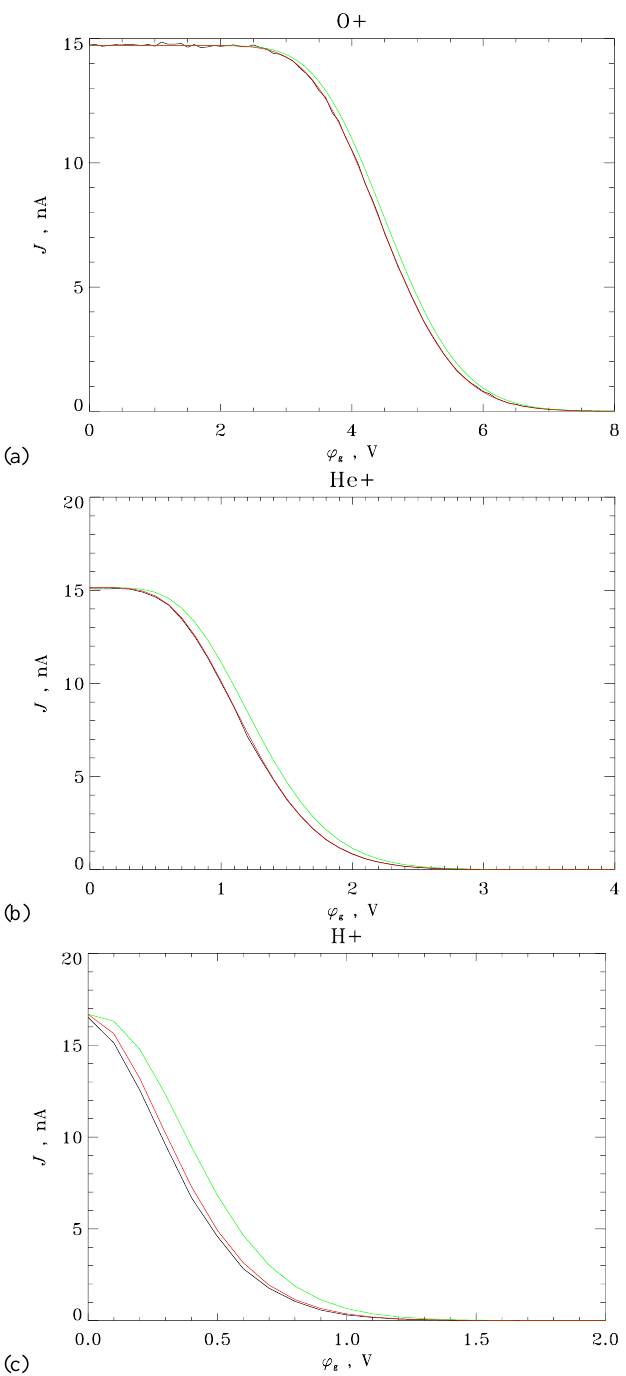
Fig. 2. Current-voltage response of the APR analyser to O + (a) , He + (b) and H + (c) , with T i = 0 . 086eV and n i = 10 10 m − 3 , as computed using the numerical code (black line) and the 1-D ∗ so- lution for the ion flux with the effective section of the entrance di- aphragm (red line). Green lines represent a 3-D analytical solution in which the losses of the particles are not taken into